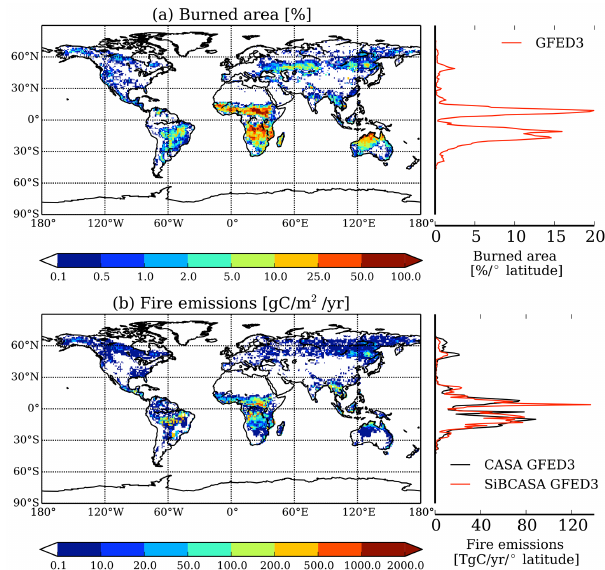
Figure 3. The (a) annual burned area (% per 1 ◦ × 1 ◦ ) from CASA- GFED3 and (b) SiBCASA’s fire emissions (gCm − 2 yr − 1 ) aver- aged over 1997–2009. The color scales in both panels are nonlin- ear. The panels on the right-hand side display the zonal averages of burned area and fire emissions per degree latitude, respectively. The fire emissions are the product of burned area and the amount of standing biomass (fuel consumption). Neglecting emissions from organic soils explains the underestimation in the Northern Hemi- sphere compared to CASA-GFED3 (black